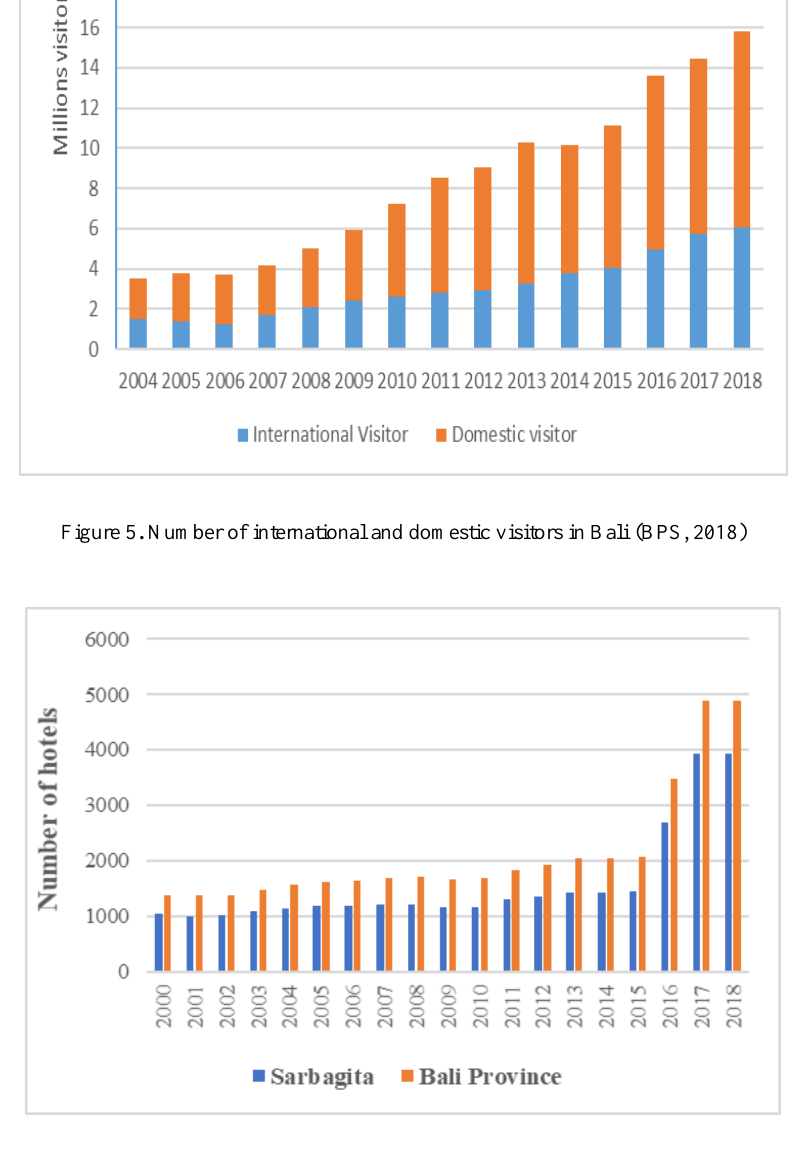
Figure 6 . Number of hotels in Sarbagita area and Bali